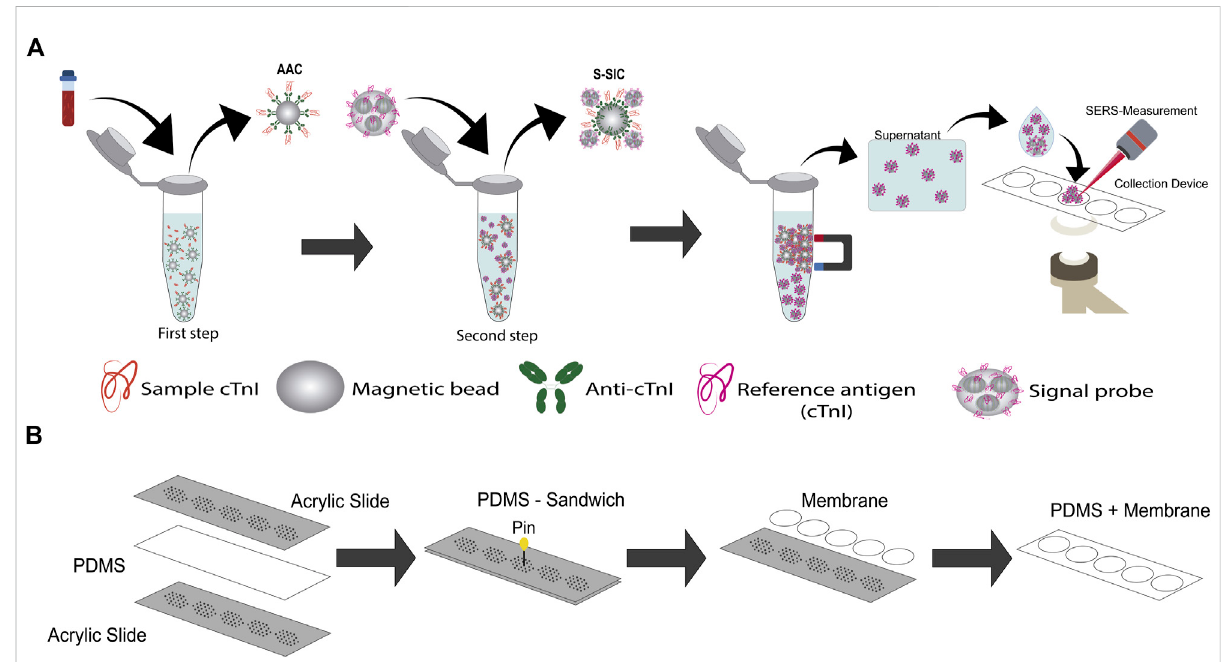
FIGURE 7 SERS-based competitive immunoassay proposal by (A) Garza and Cote (2017) under the principle of sequential saturation, adapted from Garza and Cote (2017), homemade collection device used for the SERS experiments in incise (B)